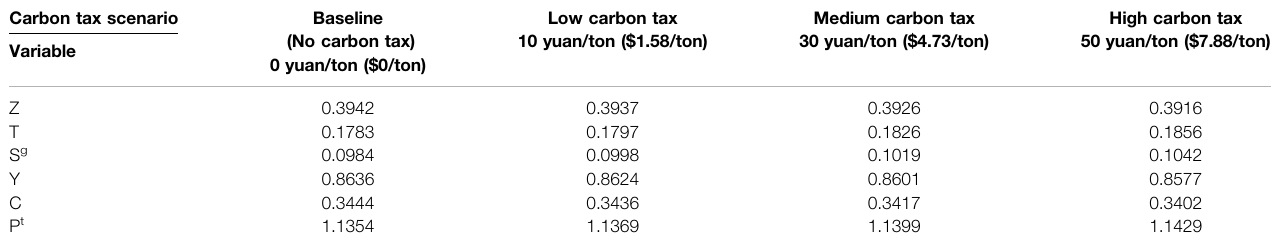
TABLE 4 | Simulation results in the carbon tax policy scenario.